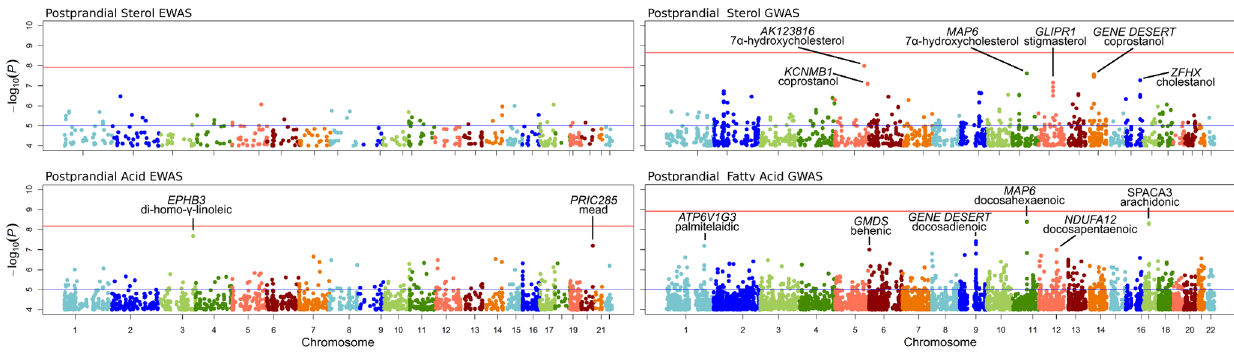
Figure 3. Manhattan plots for markers with P , 0.0001 from epigenome-wide association study and genome-wide association study. Phenotypes include 11 postprandial sterols and 35 postprandial fatty acids after adjustment for fasting concentration.